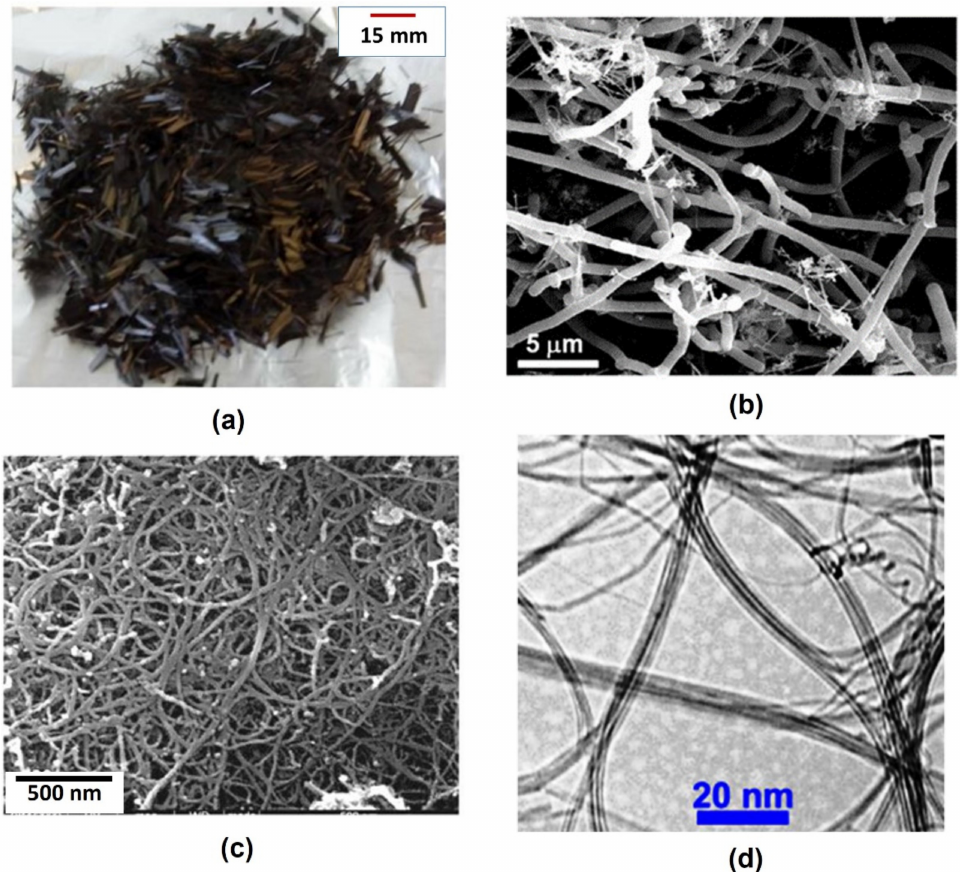
Figure 6. Reinforcement of cementitious composites: ( a ) short CFs, ( b ) SEM micrograph of CNFs and ( c ) SEM micrograph MWCNTs and ( d ) TEM image of MWCNTs, taken from manufacturer